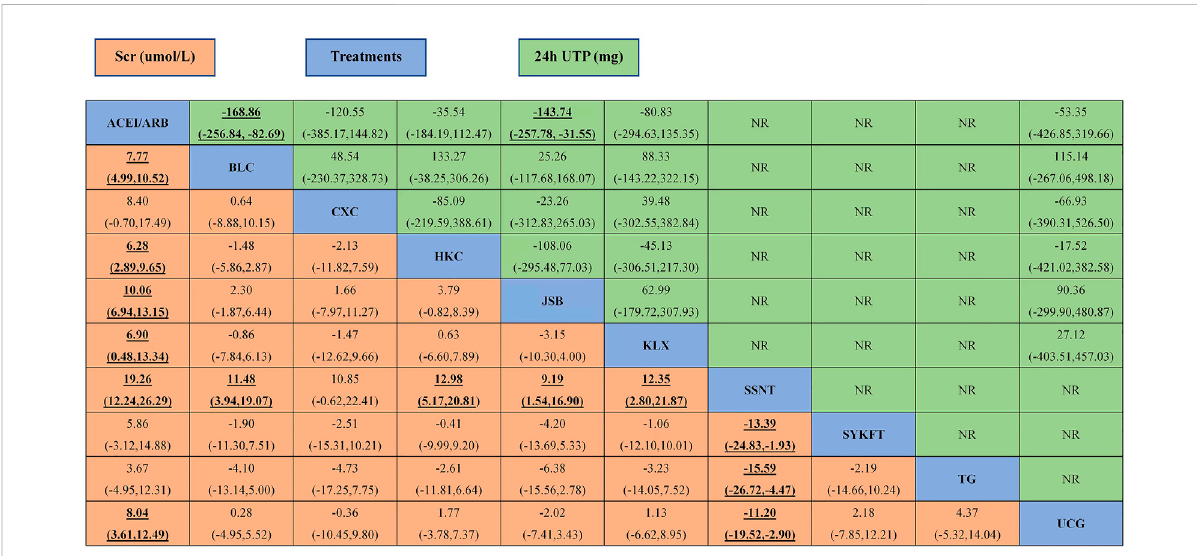
Figure S3. Based on the value of SUCRA, KLX was ranked fi rst (SUCRA of 90.2%), and the worst treatment was ACEI/ARB, with 0.5% of SUCRA (See Table 1 for more detailed information).